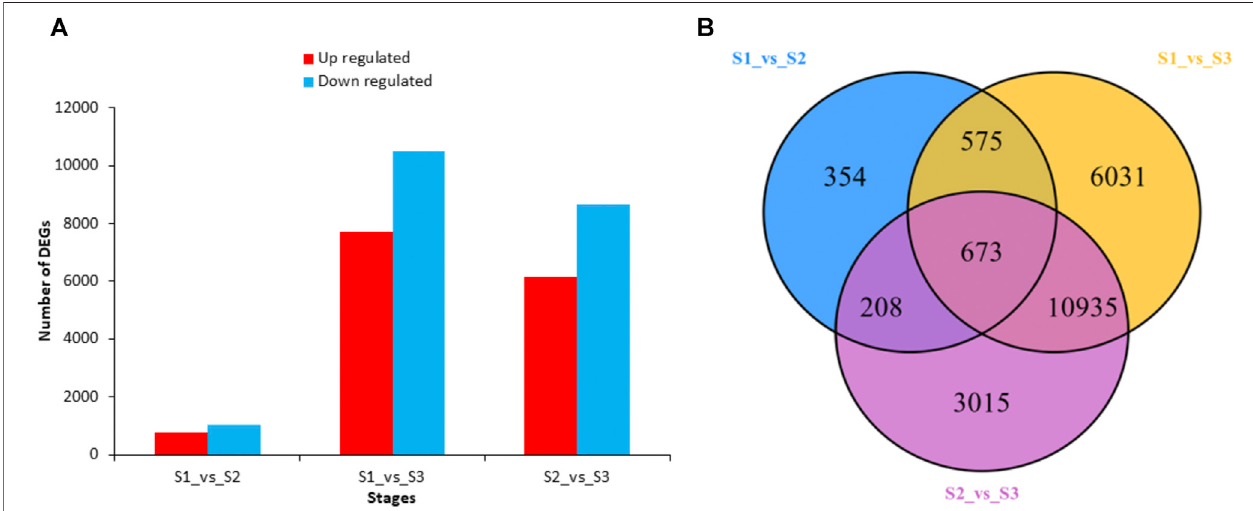
FIGURE 5 | The total number of up-regulated and down-regulated DEGs and their distribution at three developmental stages of M. ternifolia nutshell (A) Total number of up-regulated and down regulated DEGs (B) The distribution of DEGs among the developmental stages.